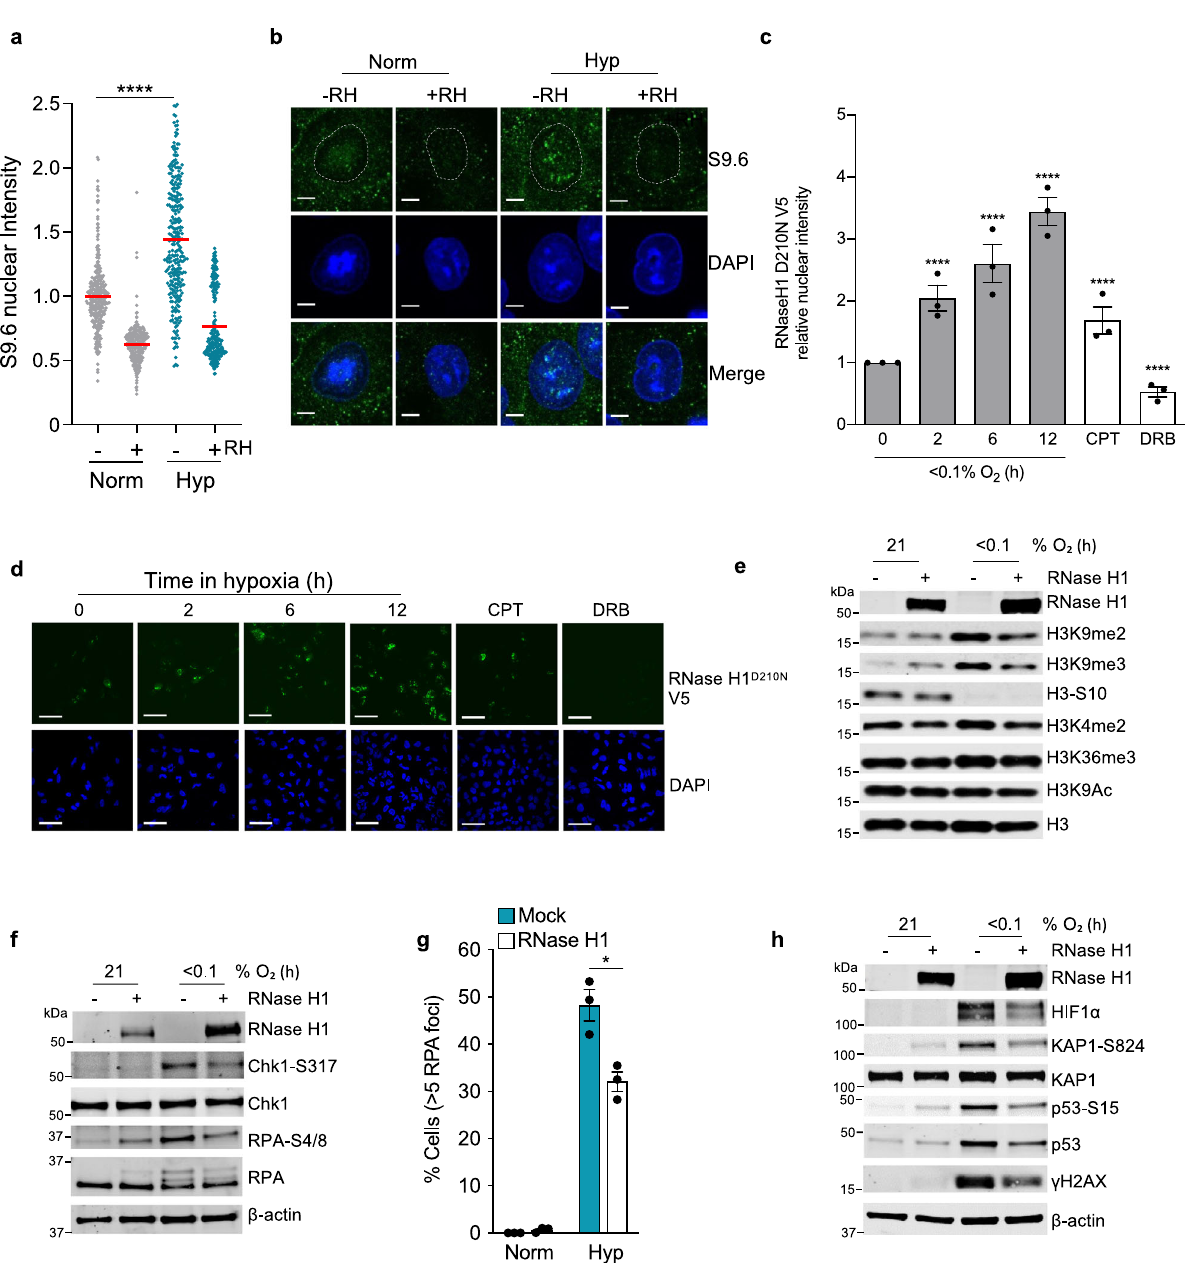
Fig. 3 Accumulation of R-loops in hypoxia (<0.1% O2). a A549 cells were exposed to 21% O 2 or <0.1% O 2 (shown in green) for 12 h, fi xed and stained with the S9.6 antibody and DAPI. Where indicated, coverslips were treated with RNase H prior to staining. Data from three independent experiments ( n = 3) where each dot represents a cell and a minimum of 100 cells were imaged per treatment. One-way ANOVA Tukey ’ s multiple comparisons test was used, **** p < 0.0001. b Representative images from a (scale bar: 5 μ m). A dashed white line indicates a nuclear outline based on a DAPI stain that was used to measure the nuclear S9.6 intensity. c A549 cells were transfected with RNase HI D210N V5 and exposed to hypoxia (<0.1% O 2 ), CPT (10 µ M, 20 min), or DRB (100 µ M, 1 h). Staining for V5 was then carried out and the nuclear intensity determined. The two-tailed Student ’ s t -test was used: **** p < 0.0001. d Representative images from part c are shown (scale bar: 30 μ m). V5 staining is green, DAPI to show the nucleus is blue. e HCT116 cells were transfected with mock or RNase H1 plasmid and exposed to 21% O 2 or <0.1% O 2 for 6 h. RNase H1 overexpression was con fi rmed by western blot analysis. Changes in chromatin modi fi cations H3K9me2, H3K9me3, H3-S10, H3K4me2, H3K36me3, and H3K9Ac are shown. Total H3 was included as a loading control. f HCT116 cells were treated as in part e (<0.1% O 2 for 6 h). The levels of RPA-S4/8 and Chk1-S317 are shown. RPA, Chk1, and β -actin controls were included. g HCT116 cells transfected with mock or RNase H1 plasmid and exposed to 21% O 2 (Norm) or <0.1% O 2 (Hyp) for 6 h were stained for RPA and the % of cells with >5 RPA foci determined. Two-tailed Student ’ s t -test was used: p = 0.0142. h Western blotting was carried out on cells treated as in part g . ATM activation was detected using KAP1-S824, p53-S15, and γ H2AX. Total KAP1, p53, H3 and β -actin control westerns were included. a – h Data from three independent experiments ( n = 3), mean ± standard error of the mean (SEM) are displayed unless otherwise